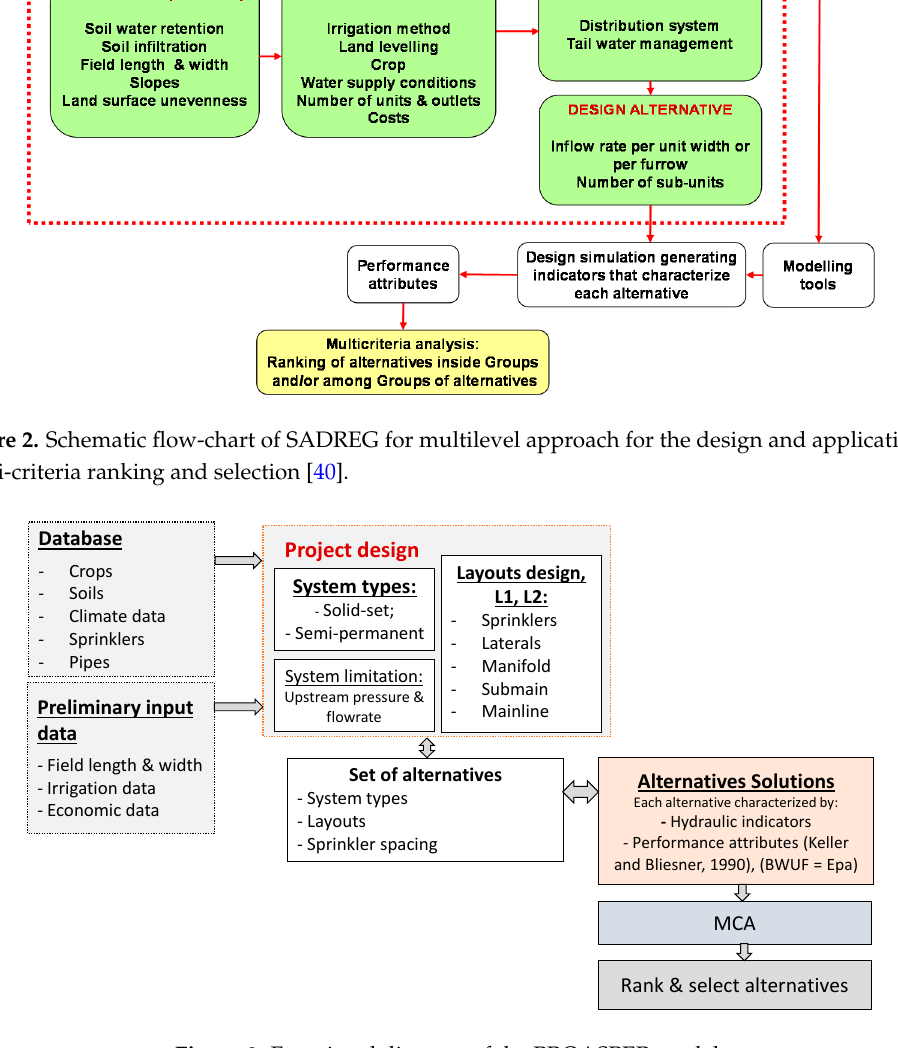
Figure 3. Functional diagram of the PROASPER model.